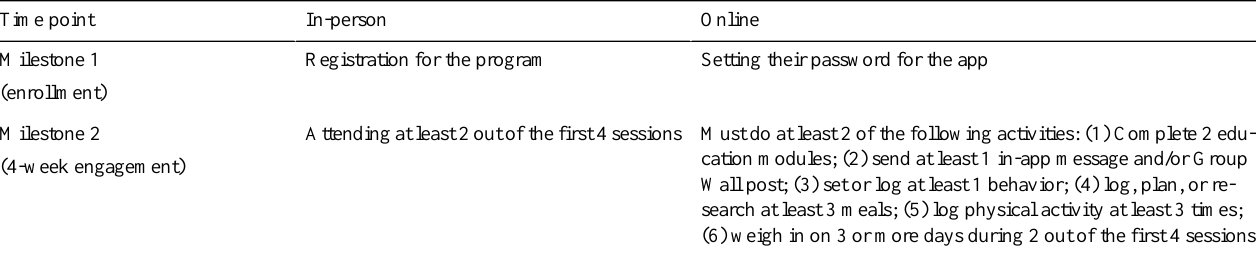
Table 1. Centers for Disease Control and Prevention (CDC)–defined measure of enrollment and engagement in in-person and online Diabetes Prevention Program’s Lifestyle Change Programs (DPP